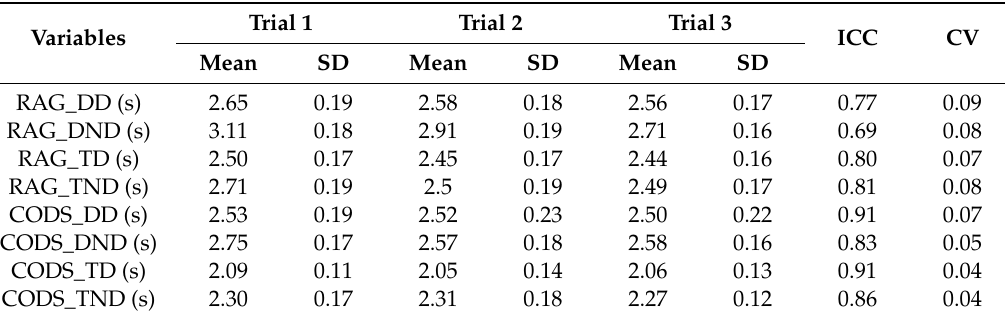
Table 3. Intra-session reliability of the tests.